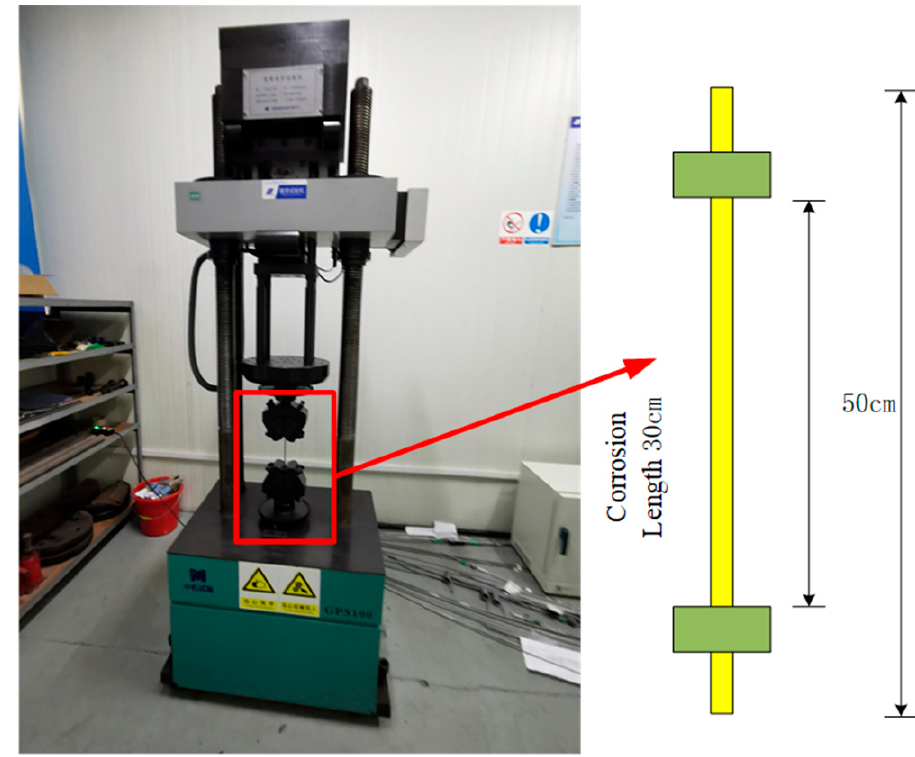
Figure 1. Area diagram of corroded steel wire.